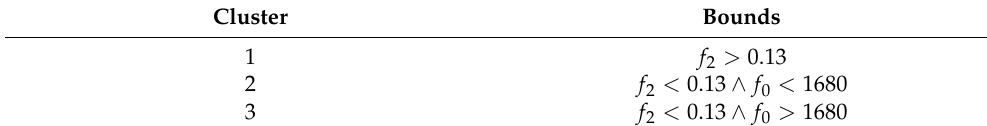
Table 2. Objective space bounds for each of the clusters as shown in Figure 1. Cluster